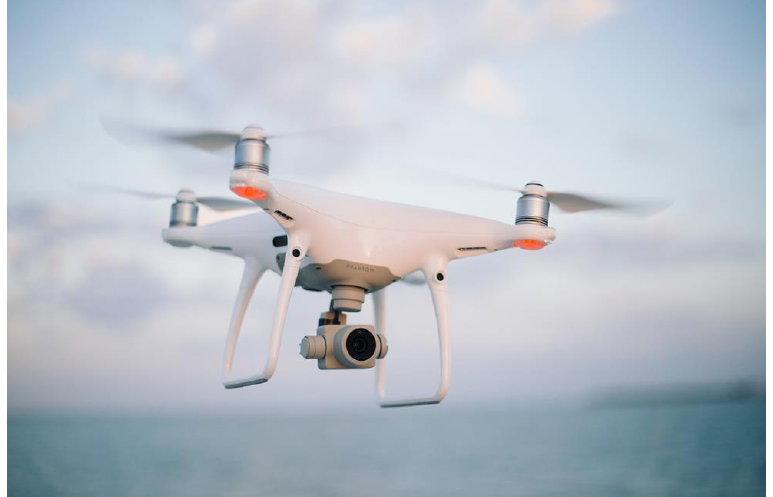
Figure 3. Rotary-wings UAV.